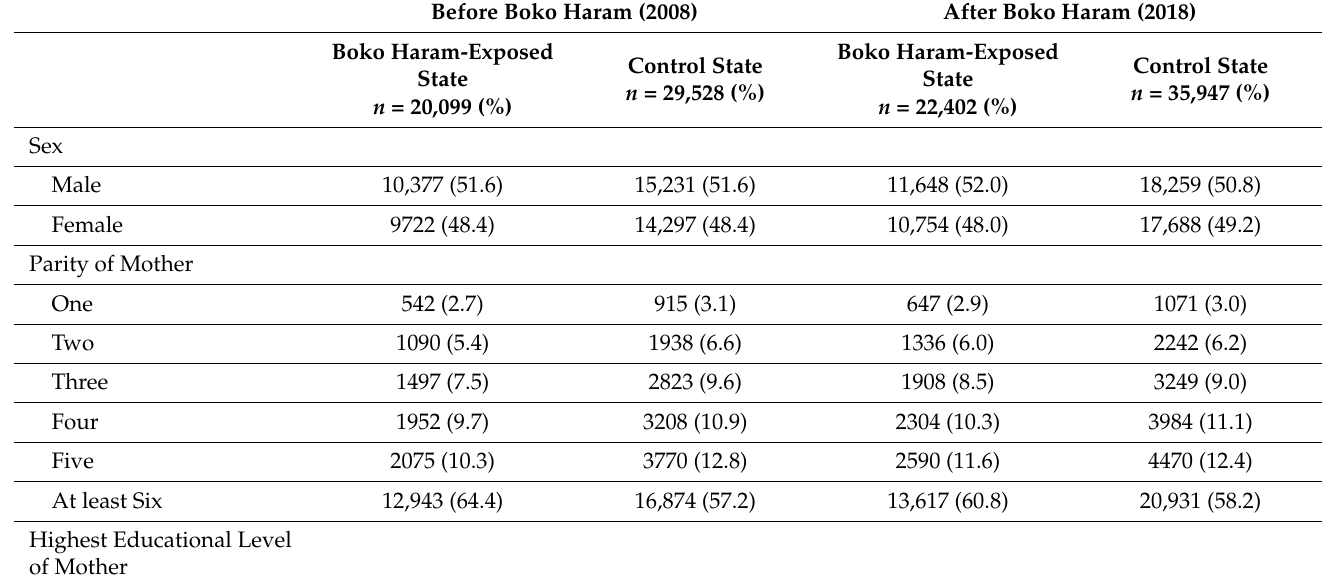
Table 1. Descriptive Statistics of Select